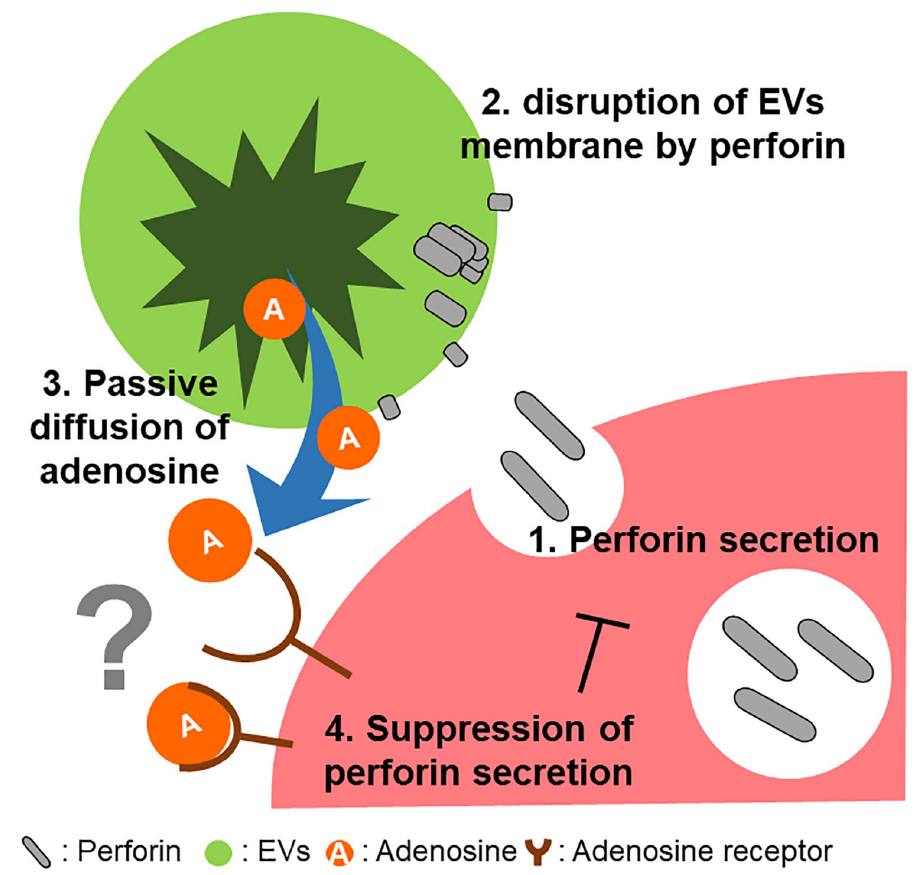
Fig 6. Schematic illustration of the relationship between perforin-mediated EV destruction and adenosine release from EVs into the tumor microenvironment. EVs contain adenosine (Tables 1 and 2, and Fig 4C). Adenosine from EVs suppresses immune responses as follows: 1) perforin is secreted by CTLs; 2) perforin inserts into and destroys the EV membrane (Figs 1 and 2); 3) adenosine diffuses passively out of EVs (Fig 2); 4) adenosine suppresses